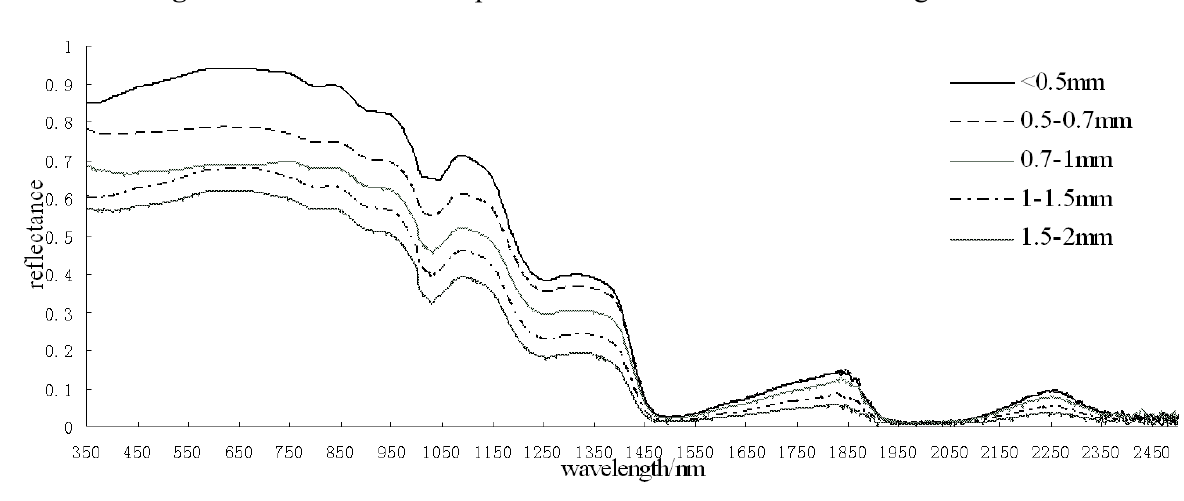
Figure 6. Variation in the spectral reflectance at different snow grain sizes.